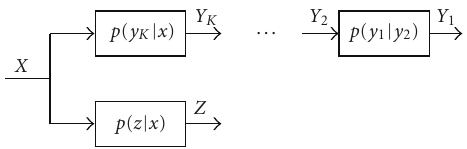
Figure 2: The degraded multireceiver wiretap channel with a more noisy eavesdropper.